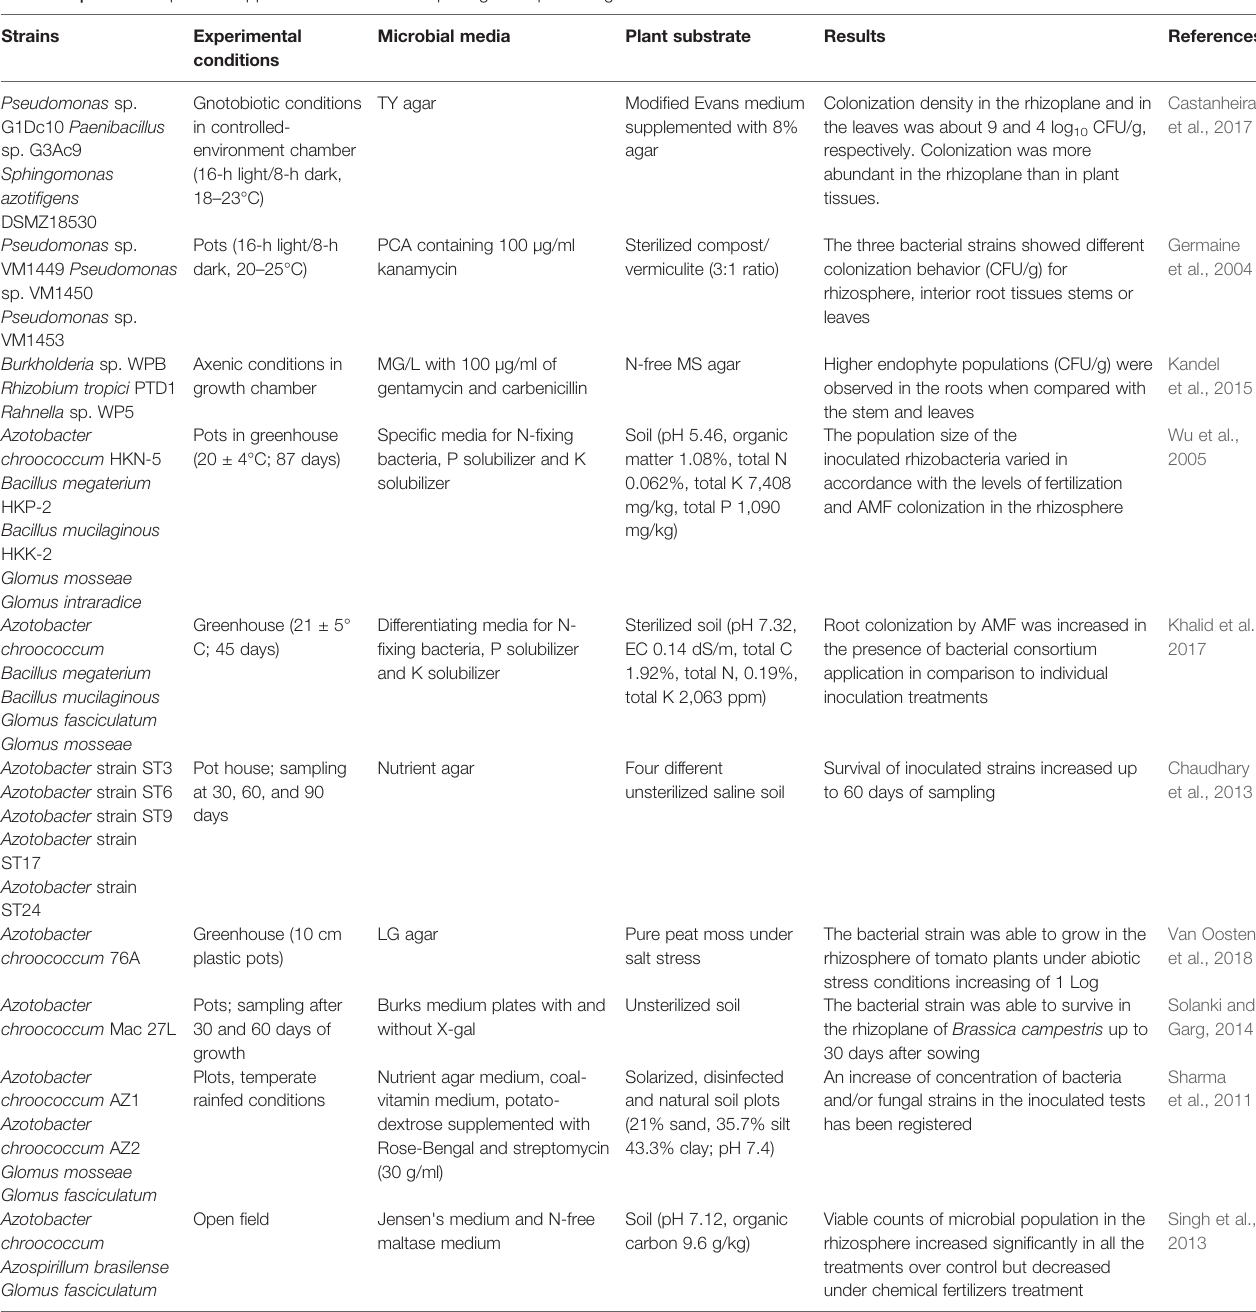
TABLE 1 | Culture-dependent approach used to monitor plant growth-promoting bacteria and root